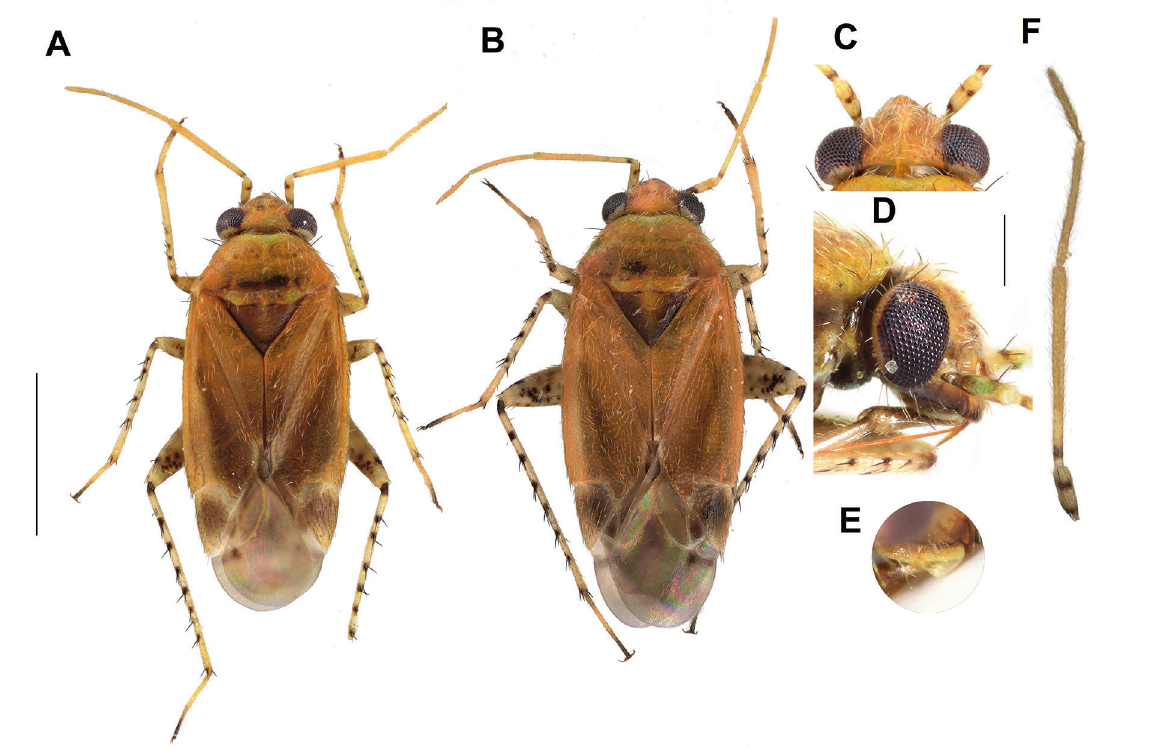
Fig. 2. Plagiognathus ozgurkocaki sp. nov. A . ♂, holotype (LEMT). B . ♀, paratype (LEMT). C . Head from dorsal view, ♂, paratype (LEMT). D . Head from lateral view, ♂, paratype (LEMT). E . Variability of buccal plate, ♂, paratype (LEMT). F . Antenna, ♂, paratype (LEMT). Scale bars: A–B = 1 mm; C–F = 0.25